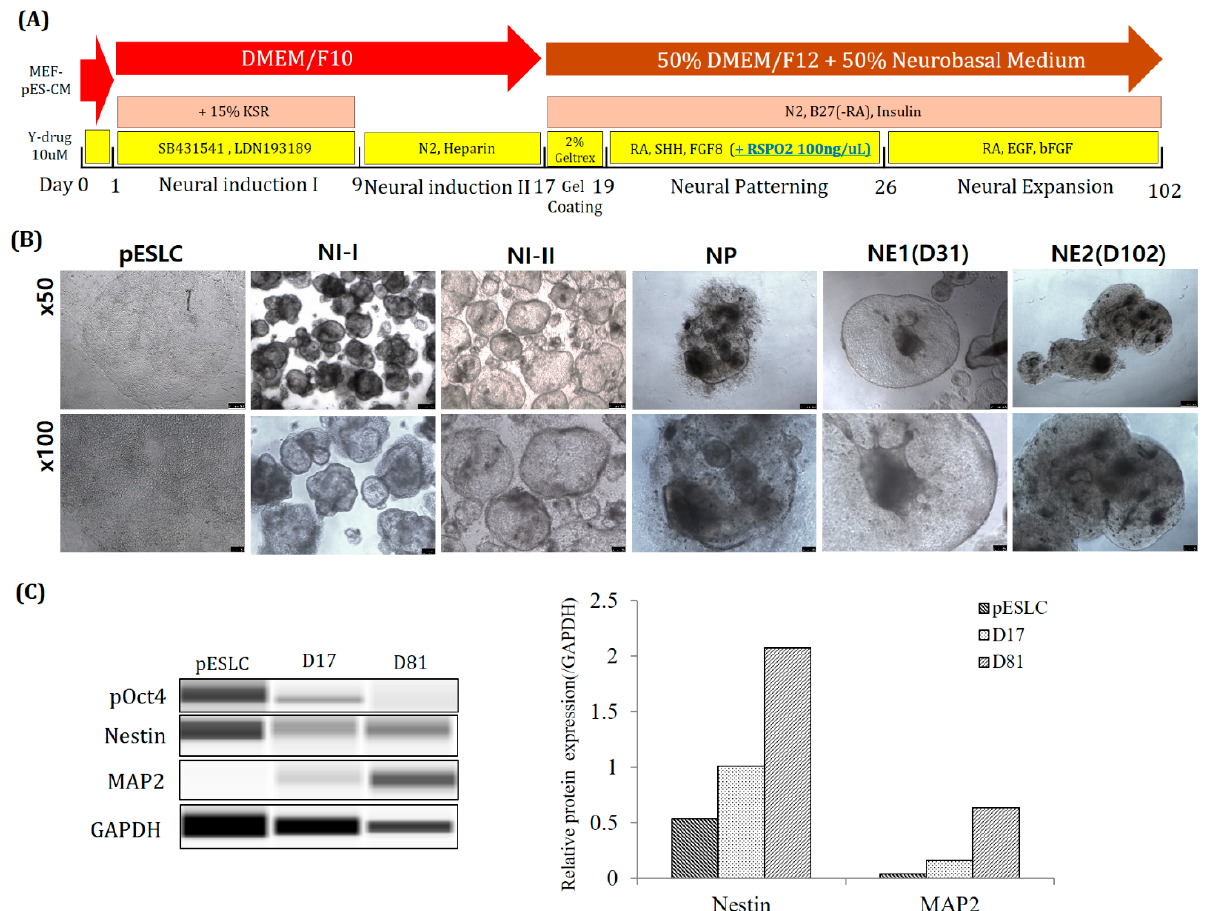
Figure 7. (Long-term) Progression of 3D Neuro-organoid development from Yucatan EGFP pESLCs. ( A ) Schematic diagram of the 3D neuro-organoid method and timing. ( B ) Image of neuro-organoid according to differentiation stage. Scale bar: ×50 = 250 um, ×100 = 100 um. ( C ) Result of Western blot.